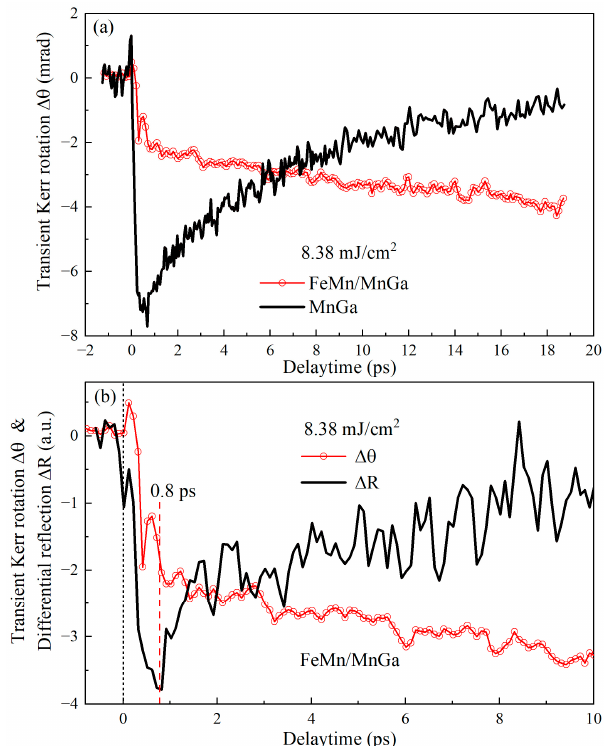
Figure 3. ( a ) The ultrafast demagnetization dynamics of FeMn/MnGa (open circles) and MnGa (solid line). ( b ) Short temporal traces of the Kerr signal (open circles) and transient reflectivity (solid line) of FeMn/MnGa upon photoexcitation.